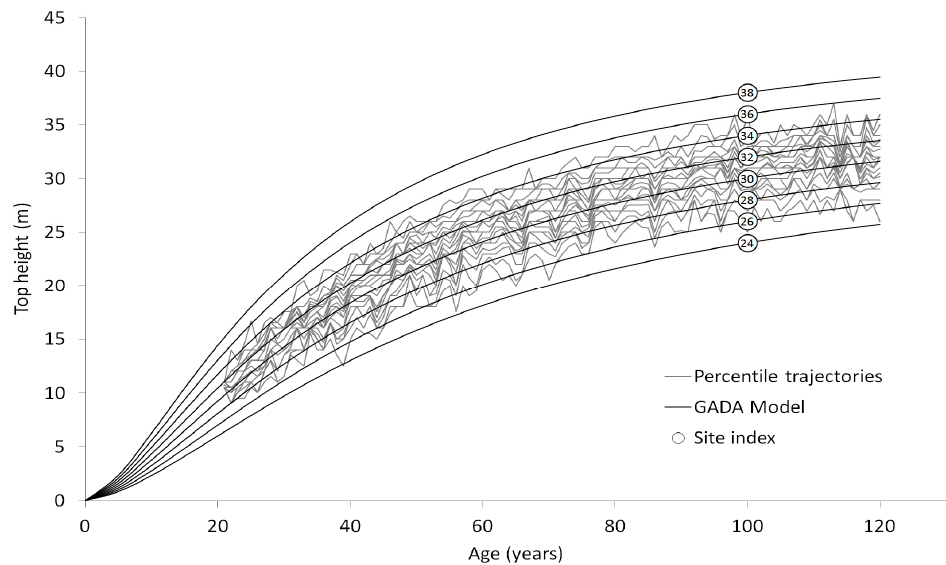
Figure 4. Top height growth trajectories for Scots pine determined by the proposed method, using top height percentiles from TSPs calculated for the individual ages of the stands. The values in circles represent the corresponding site index at the base age of 100 years. GADA: generalised algebraic difference approach.